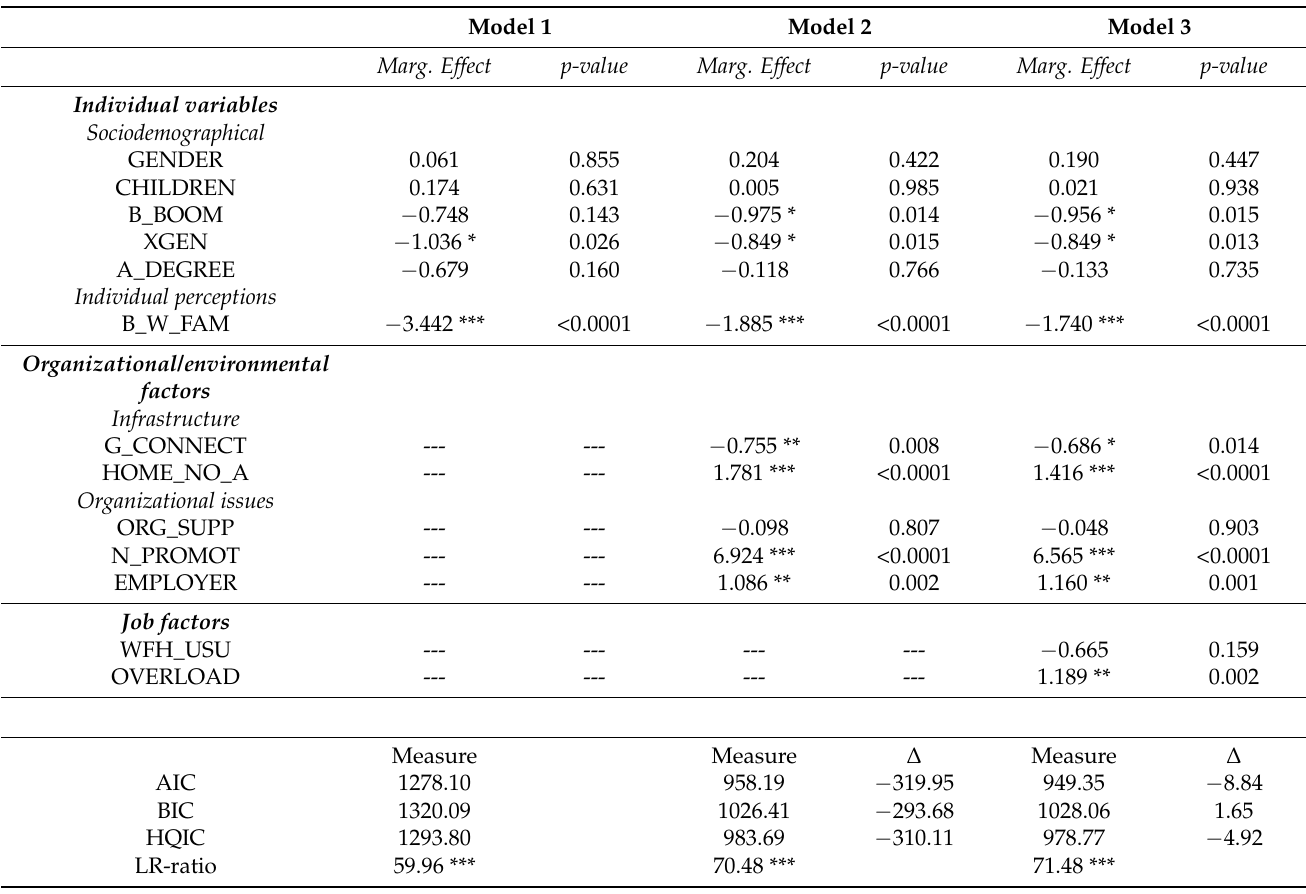
Table 4. Results of hierarchical tobit regressions for